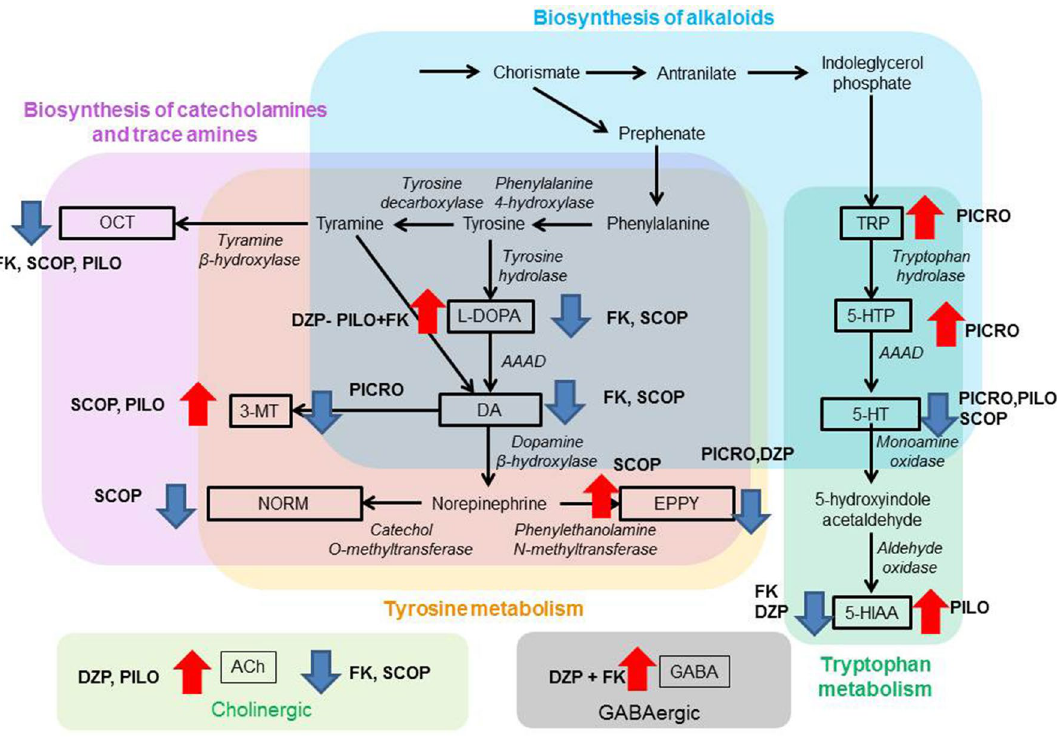
Figure 4. Affected metabolites depicted in KEGG pathways following Fuertes et al. 26 . Black-boxed metabolites are those that show significant treatments differences. In italics, the catalytic enzymes of the reactions of interest are detailed. Arrows and the compounds associated to them indicate the direction of the observed treatment effect according to Fig.